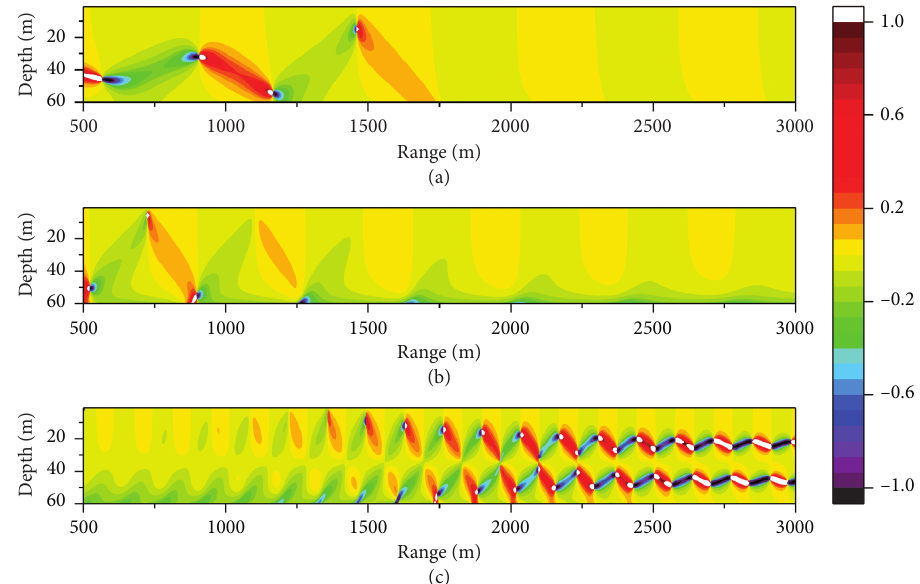
Figure 16: I ∗ z for different seismic wave speeds when